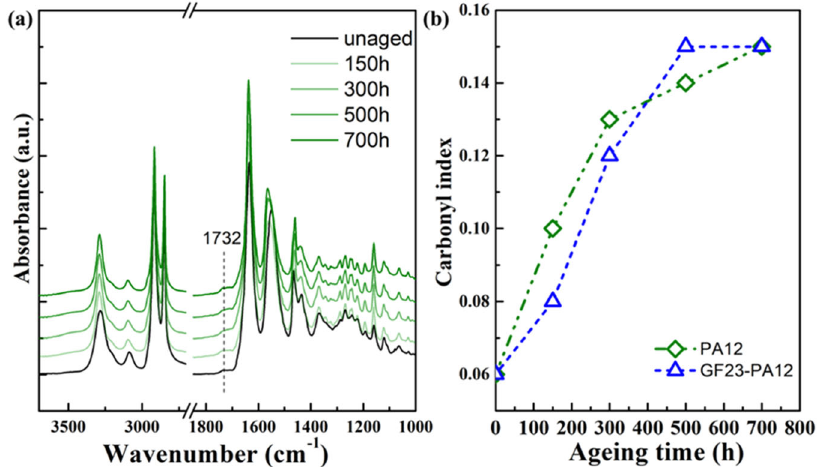
Fig. 6 Oxidation of the PA12 samples. a FTIR spectra of the unaged and aged PA12 samples, and b carbonyl index of the PA12 and GF23- PA12 samples plotted as a function of ageing